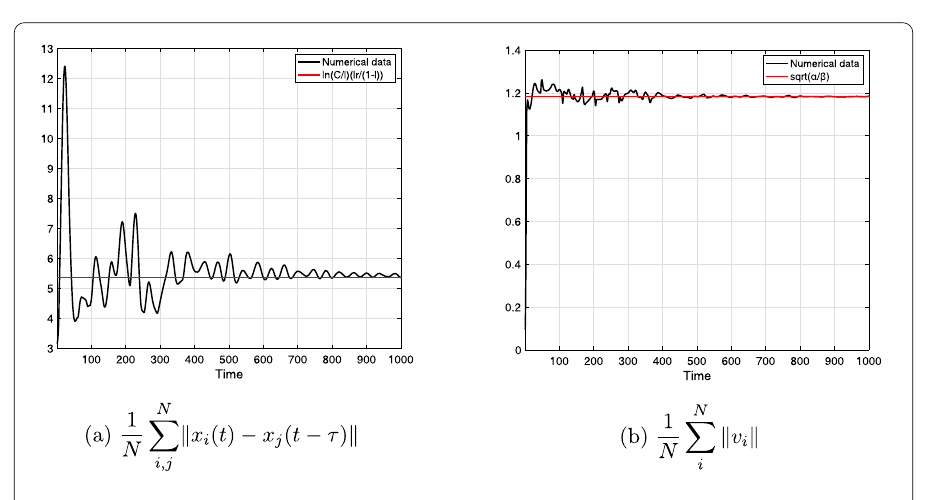
Figure 15 The average distance between agents and average velocity of agents of Case I for t ∈ [0,1000]. Panel ( a ) shows the comparison of the average distance between agents with the value lr shows the average velocity of agents compared with the value